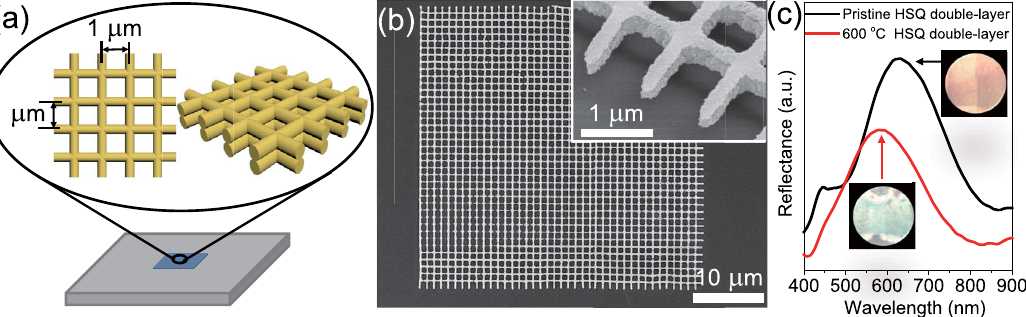
Fig. 6 Biomimetic structural colour with thermal resistance via HSQ double-layer microstructure constructed by FsLDW. a Schematic illustration of the con fi guration design of the HSQ double-layer microstructure with structural colour. b SEM image of HSQ double-layer microstructure constructed by FsLDW. The inset is the magni fi ed tilted SEM image of the HSQ double-layer microstructure. c Re fl ectance spectra of the HSQ double-layer microstructure before (black) and after (red) 600 °C treatment. The inset exhibit the structural colour of the double-layer HSQ microstructure before and after 600 °C yellow green (inset of Fig. 6c). Accordingly, the Bragg peak is microstructure during the heating process. Although structural transferred from 631 to 583 nm (Fig. 6c). Since the refractive colour has been achieved by the combination of metal layers and index is slightly decreased from 1.380 (multi-photon cured HSQ, HSQ microstructures constructed by e-beam lithography 30,66 , Supplementary Fig. S13) to 1.375 (thermal treatment of multi- HSQ microstructures by FsLDW provide a simple and direct photon curved HSQ at 600 °C, Supplementary Fig. S13), the blue- method to construct structural colour. The biomimetic structural shift of the Bragg peak is mainly attributed to the decreased colour of HSQ microstructures with thermal resistance will refractive index and the shrinkage of the HSQ double-layer exhibit potential widespread applications in harsh conditions.